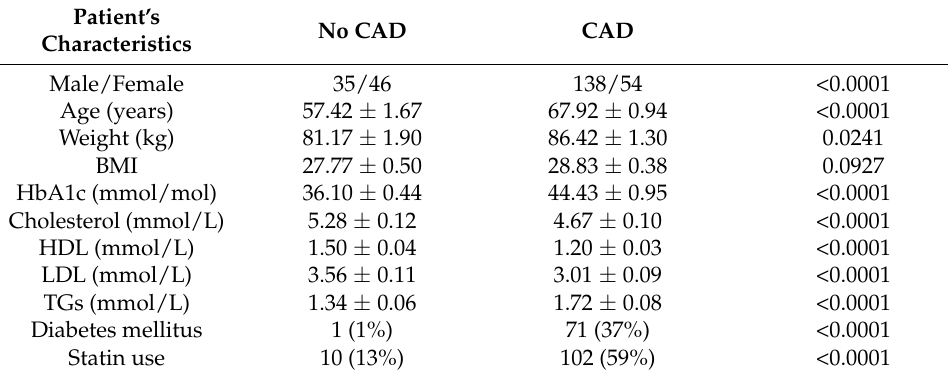
Table 1. Differences between the groups were tested with the unpaired Student’s t -test and Chi-square test. Data are presented as mean ± standard error of the